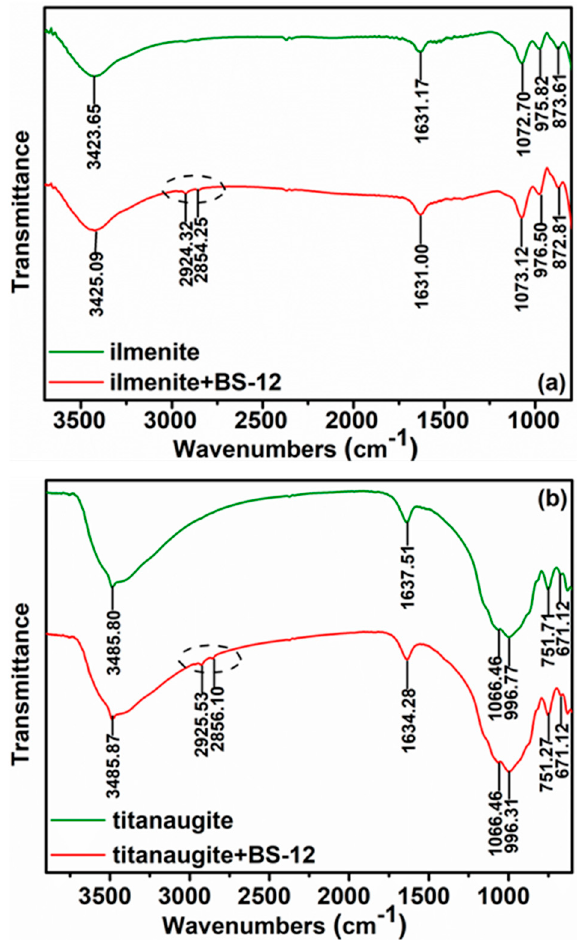
Figure 7. FT-IR spectra of ilmenite ( a ) and titanaugite ( b ) before and after the addition of BS-12.